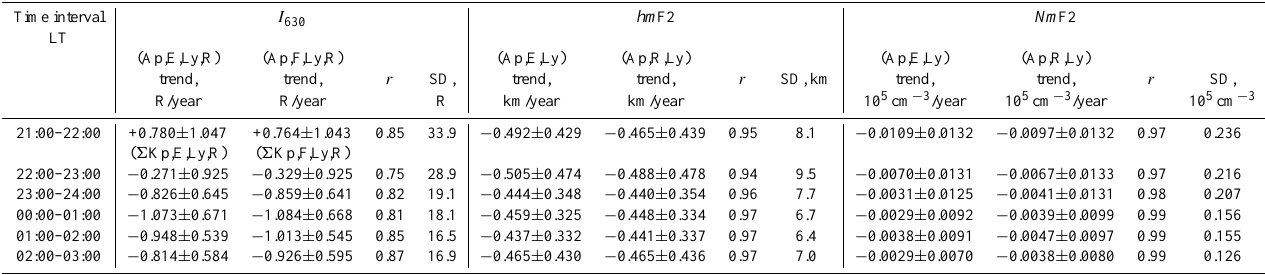
Table 1. Trends, mean correlation coefficients r (between X exp and X th ) , standard deviations (for 1X) of the mean annual oxygen red 630.0nm line nightglow intensity I 630 observed at Abastumani (41.75 ◦ N; 42.82 ◦ E) in 1957–1993 and the ionosphere F2 layer peak electron density Nm F2 and its height hm F2 observed at Tbilisi (41.65 ◦ N, 44.75 ◦ E) in 1963–1986 at pre-midnight and after midnight for different solar and geomagnetic indices. The trend values are given with their errors at 95% confidence